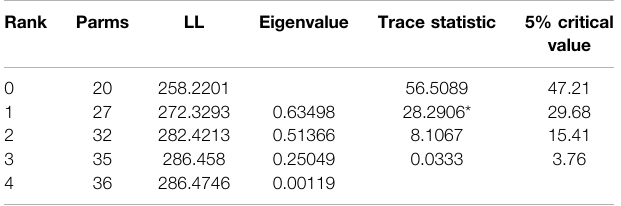
TABLE 6 | Results of Johansen co-integration